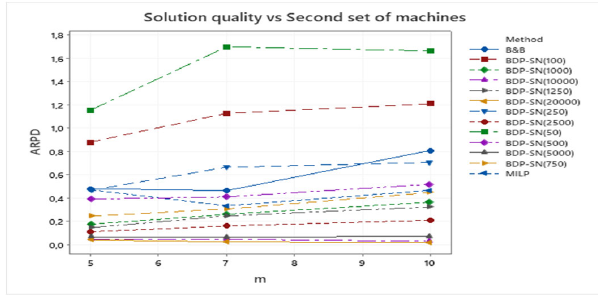
Fig. 9. ARPD variation with respect to the second group of